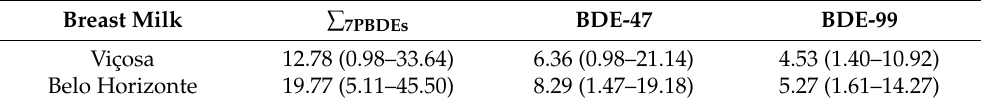
Table 5. Estimated daily intake of PBDEs by infants. The values are expressed as ng/kg/day. Breast